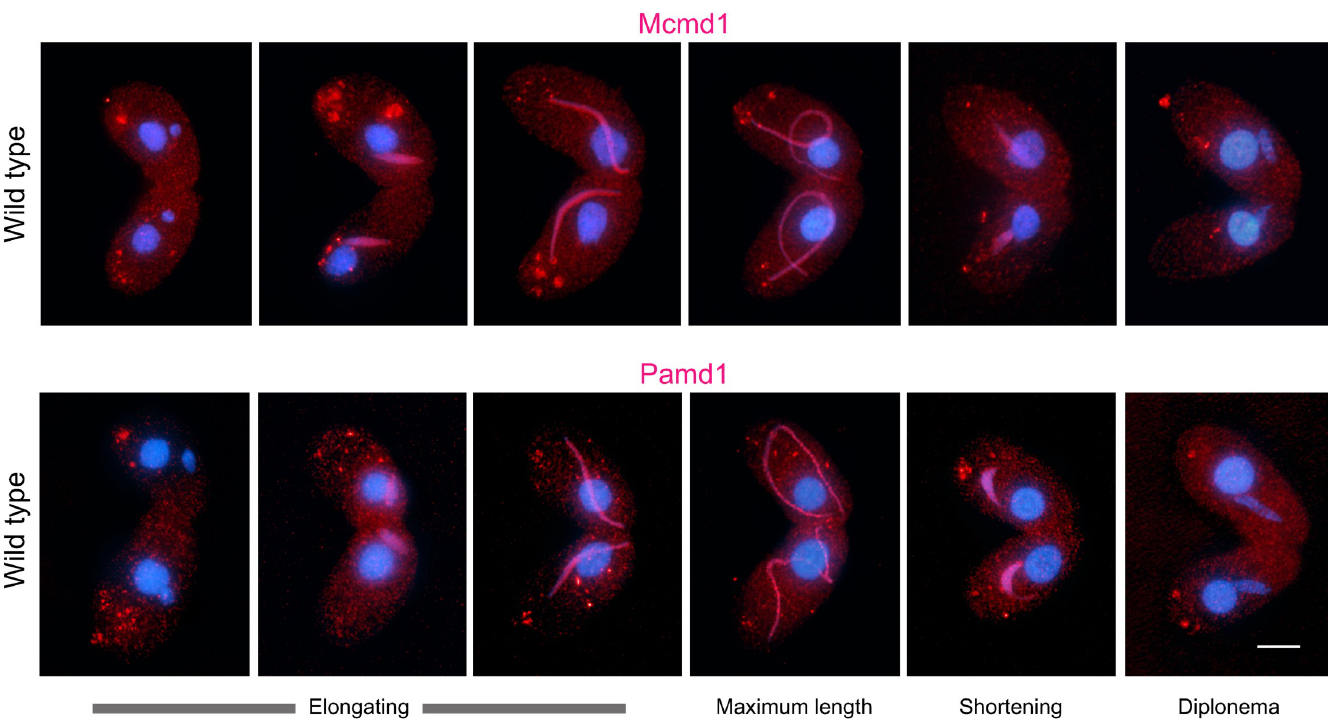
Fig 4. Wild-type localization of Mcmd1 and Pamd1. Mcmd1-HA and Pamd1-HA appear shortly after nuclei begin to elongate, are most abundant in fully elongated nuclei, disappear from shortening nuclei, and are completely gone by diplonema. This timing is the same as for Dmc1 foci (Fig 5), but Mcmd1 and Pamd1 show uniform nuclear distribution rather than foci. Bar: 10 μ